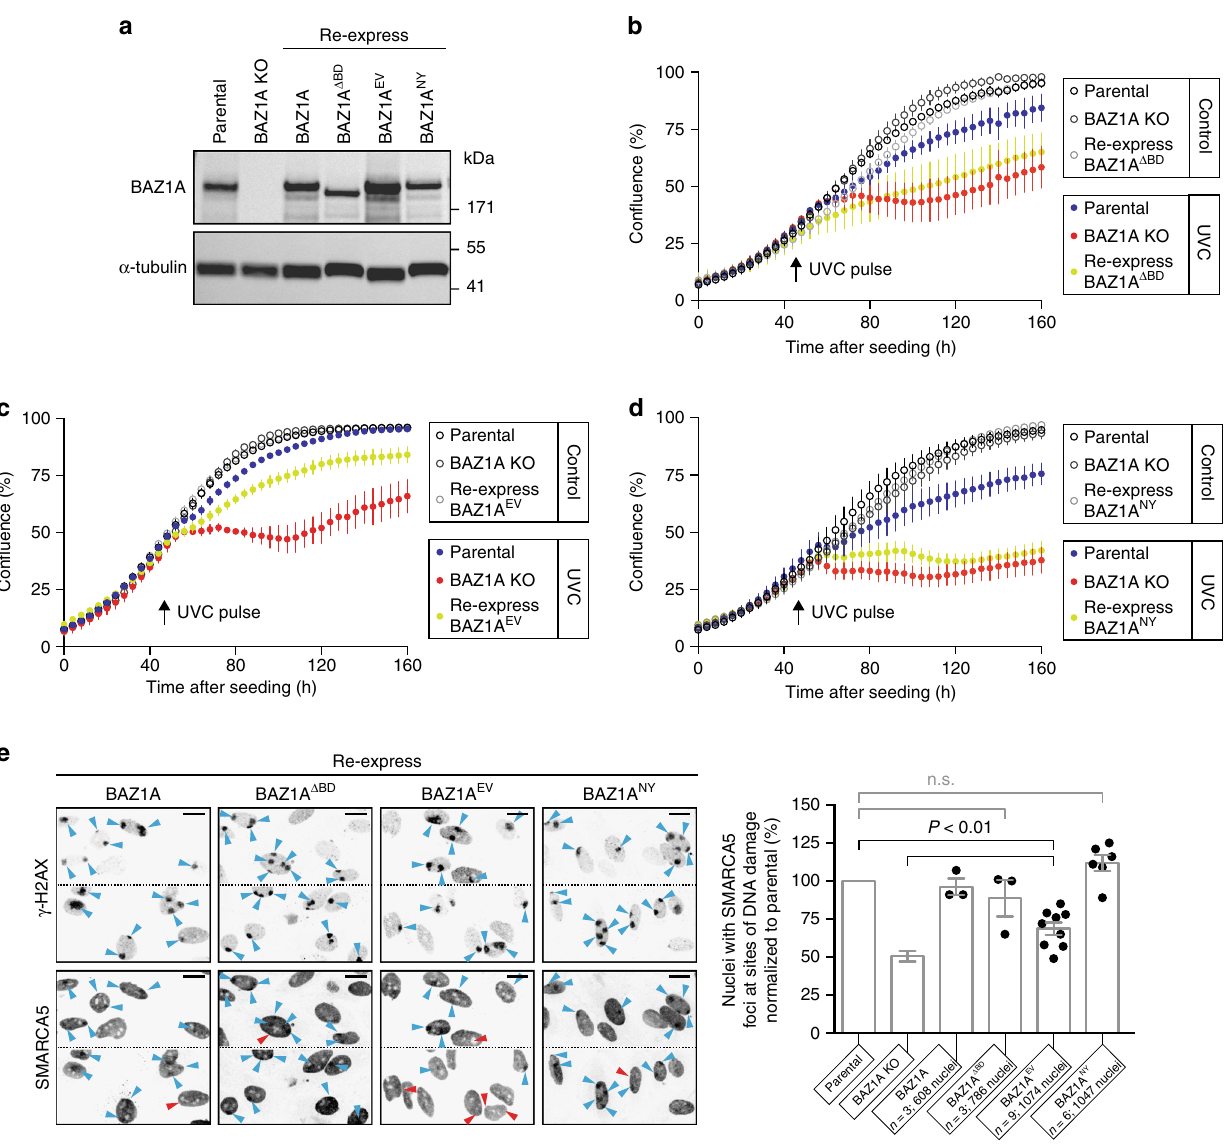
Fig. 4 The BD of BAZ1A promotes DNA damage recovery but is not required for SMARCA5 recruitment. a Western blot analysis of BAZ1A expression in parental, BAZ1A -KO, and BAZ1A -KO cells engineered to re-express wild-type BAZ1A, or the mutants BAZ1A Δ BD (1 – 1424), BAZ1A EV (E1515V), and BAZ1A NY (N1509Y). b – d Con fl uence of the indicated cell line measured over time, before, and after a pulse of UVC light. e Accumulation of endogenous SMARCA5 at sites of DNA damage as in Fig. 2c, d. Scale bar , 20 μ m. Histograms represent the mean value ± s.e.m normalized to recruitment in parental cells. P- values ( P < 0.01) were calculated using a two-tailed Mann – Whitney test; n.s . not signi fi cant ( P > 0.05) binding to DNA, and the BAZ1A-PHD K1181A/K1183Y double